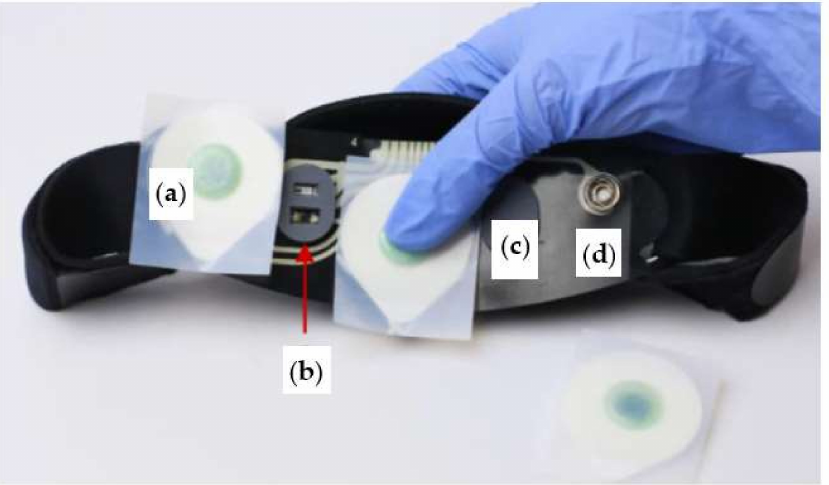
Figure 6. Internal view of Sleep Profiler headband, consisting of EEG sensor ( a ), optical sensor ( b ), strip pad ( c ), and sensor snap ( d ) [64].